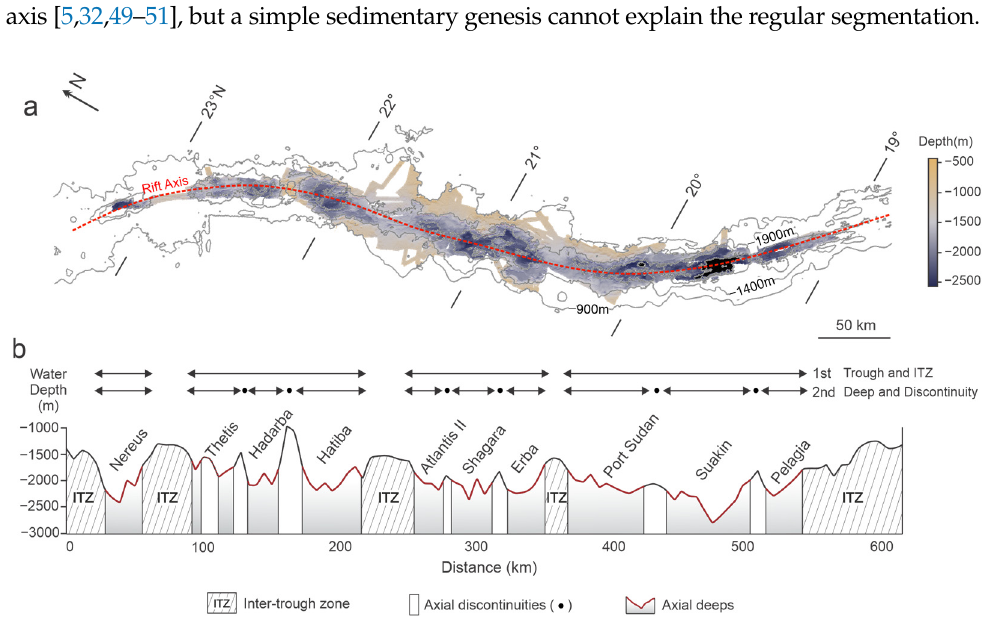
Figure 10. Segmentation of the Central Red Sea Rift axis. ( a ) Bathymetric map of the rift axis; data from Augustin et al. [34]. Grey lines are isobaths of -900 m, -1400 m, and -1900 m, respectively; data from the GEBCO Compilation Group 2021 (h tt ps://www.gebco.net, accessed on 3 September 2021). Red dash line represents the axis of the Central Red Sea Rift. ( b ) Water depth variation along the red dash line in ( a ). The red solid lines are indicators of the oceanic crust in axial deeps. Longer arrows represent the fi rst-order segments, central troughs spaced by ITZs; shorter ones represent the sec- ond-order segments, axial deeps spaced by the discontinuities (represented by the black dots). The seismic re fl ection data reveal the di ff erences in sedimentary and tectonic evolu- tion between the axial deep and the inter-trough zone. Close to the axial deep, the re fl ector S was interrupted, and Pliocene–Pleistocene strata were quite thinned or even absent. The border faults controlled the signi fi cant tectonic subsidence (Figure 4). While the inter- trough zone had a variable tectonic condition, subsidence was uniform and hardly in fl u- enced by the fault activities during the third rifting stage, and the basement was deeply buried by thick sediments (Figures 5 and 6). Correspondingly, di ff erences in the nature of the crust between the axial deeps and inter-trough zones were further revealed by gravity models. The oceanic crust is only limited in the center of deeps bounded by the normal fault systems that developed during the third rifting stage (Figure 9), whereas in the inter- trough zone the continental crust thickens (Figure 9). Besides, the Moho tends to rise un- der the main troughs and deepens under the inter-trough zones (Figure 3). Bouguer grav- ity anomaly is higher in the axial deeps than the inter-trough zone and discontinuities [35], indicating the deep structure segmentation along the rift axis. 4. Punctiform Breakup and Initial Oceanization Mechanism